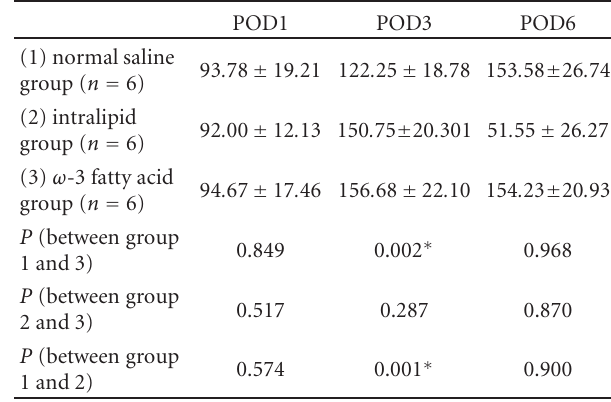
Table 3: Serum GAS (pg/mL).